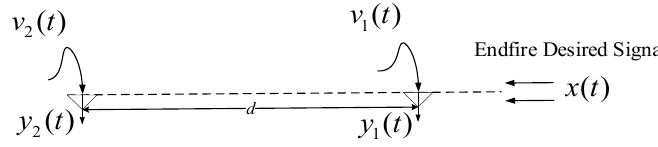
Figure 1. Dual-microphone array with end fire desired signal.